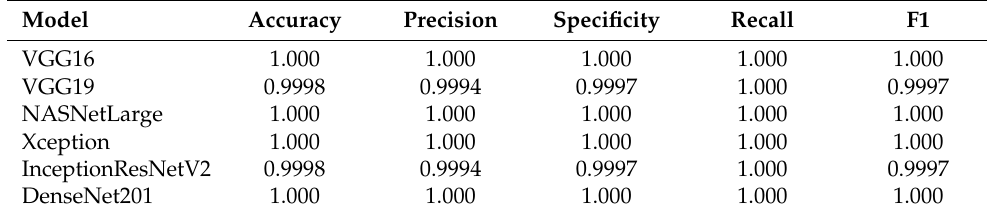
Table 2. Pre-trained Models’ Results on the Train